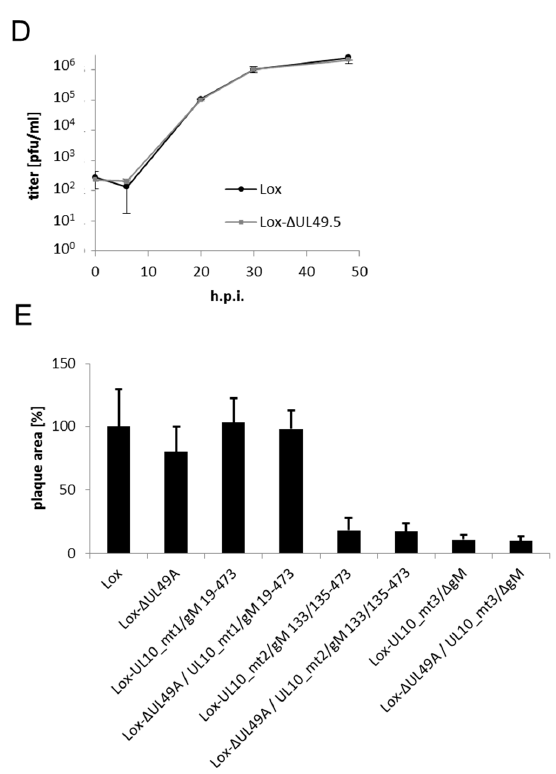
Figure 5. During infection, HSV-1 gN is nonessential and redundant in association with gM. ( A ) The schematic diagram of the pHSV1(17 + )lox genome with the unique long (UL) and unique short (US) region flanked by the terminal repeat (TR) and internal repeat (IR) regions shows the spatial distribution of the glycoprotein encoding genes UL10 (glycoprotein M, gM) and UL49.5 (glycoprotein N, gN); ( B ) Generation of HSV-1 gM mutants by interfering with three methionines that might serve as potential start codons for protein synthesis at the beginning of the open reading frame (ORF) UL10 [14]. Deletion of gM in Lox-UL10_mt1/gM 19–473 was obtained by base pair exchanges that result in a premature stop codon at position 3 of ORF UL10. In Lox-UL10_mt2/gM 133/135–473, an additional mutation leads to expression of isoleucine instead of methionine at position 19 (M19I), while insertion of the galK -kan-cassette into Lox-UL10_mt2/gM 133/135–473 leads to disruption of ORF UL10 at position 150; ( C ) Generation of HSV-1 gN deletion mutant Lox- ∆ UL49.5 by introducing base